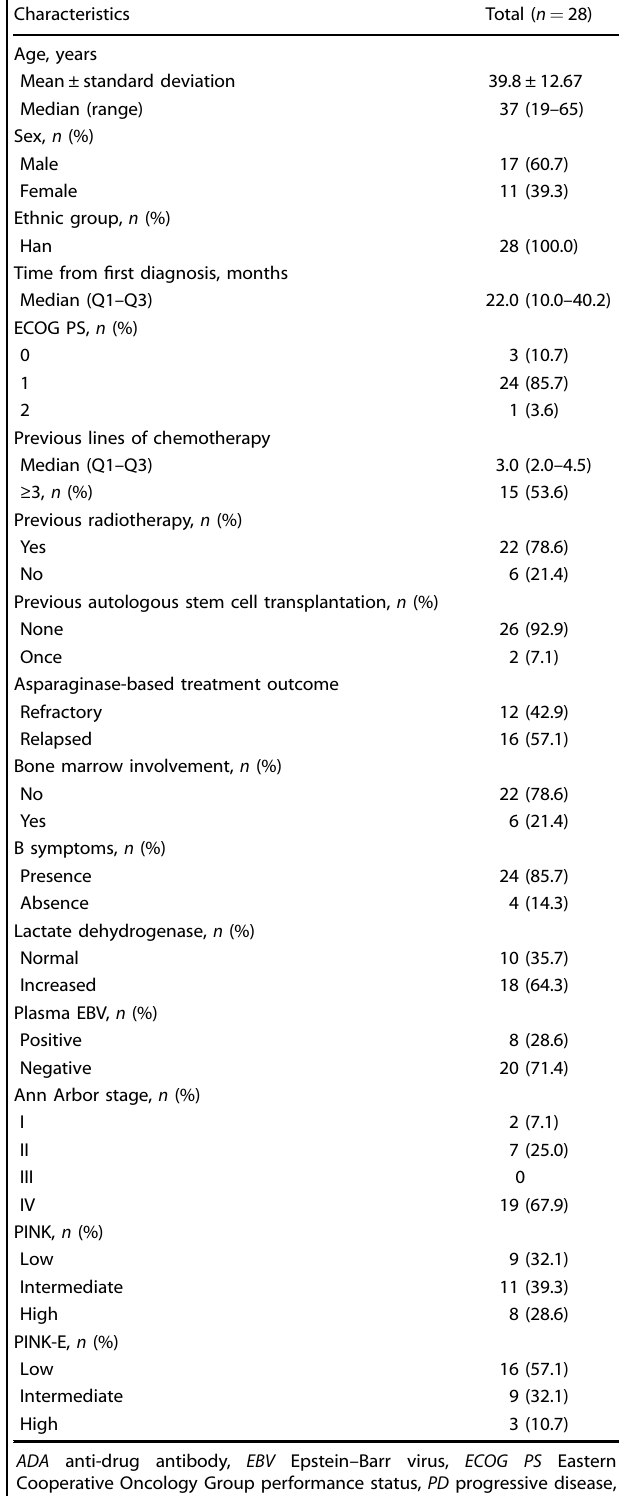
Table 1. Baseline characteristics of the